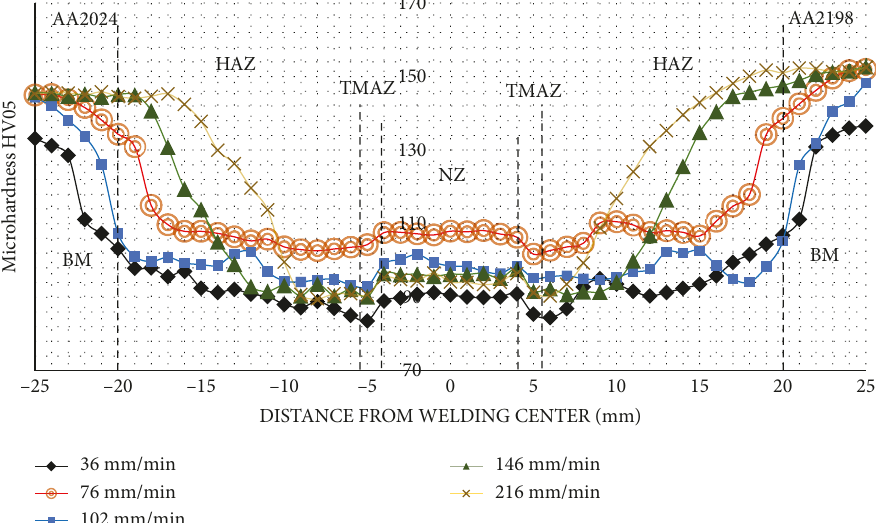
Figure 8: Microhardness values of single-sided friction stir welding (SS-FSW).